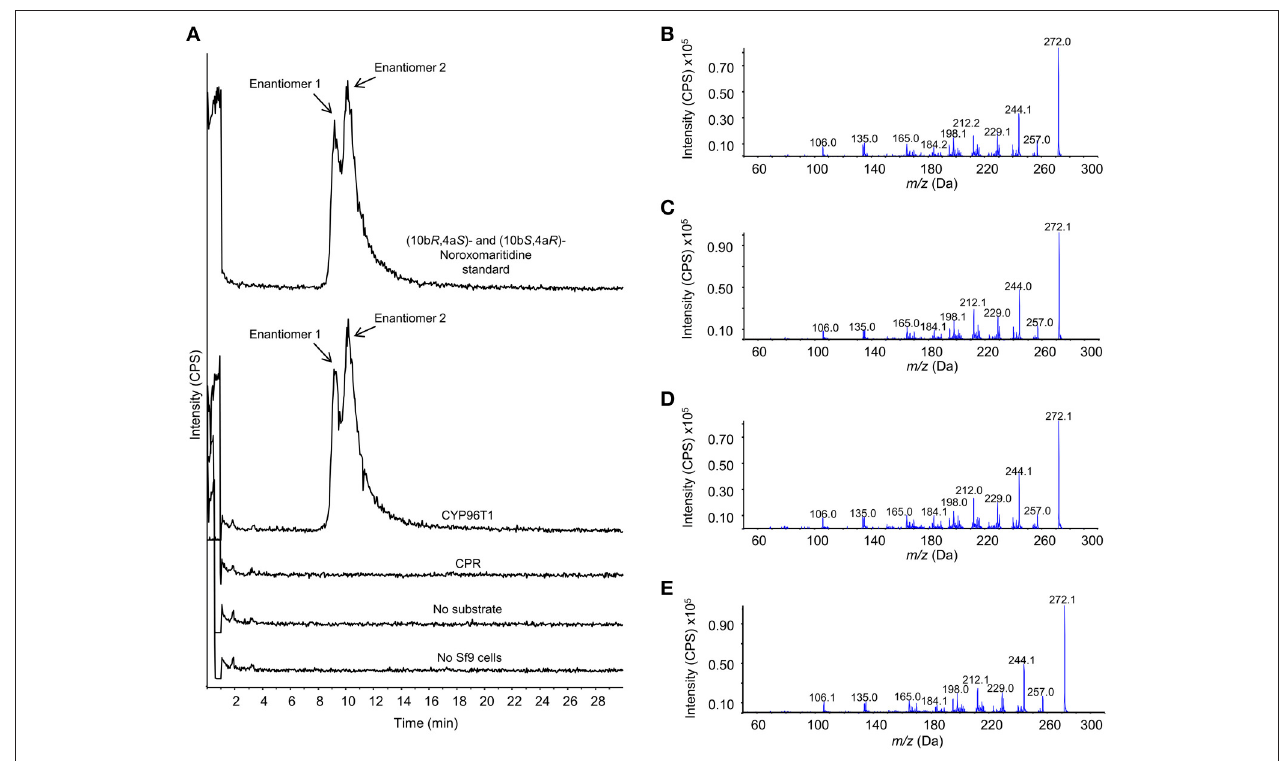
FIGURE 6 | Chromatographic separation and MS/MS analysis of the primary 4 ′ - O -methylnorbelladine products (10b S ,4a R )- and (10b R ,4a S )-noroxomaritidine. The enantiomers (10b S ,4a R )- and (10b R ,4a S )-noroxomaritidine were chromatographically separated with a chiral-CBH column and analyzed by MS/MS using an enhanced product ion (EPI) scan. (A) Samples, top to bottom: (10b R ,4a S ) - and (10b S ,4a R )-noroxomaritidine standard, CYP96T1 assay, CPR assay, CYP96T1 assay without 4 ′ - O -methylnorbelladine substrate and no Sf9 cells assay. (B) EPI fragmentation pattern for enantiomer 1 of (10b R ,4a S )- and (10b S ,4a R )-noroxomaritidine. (C) EPI fragmentation pattern for enantiomer 2 of (10b R ,4a S )- and (10b S ,4a R )-noroxomaritidine. (D) EPI fragmentation pattern for enantiomer 1 in the CYP96T1 assay with 4 ′ - O -methylnorbelladine as substrate. (E) EPI fragmentation pattern for enantiomer 2 in the CYP96T1 assay